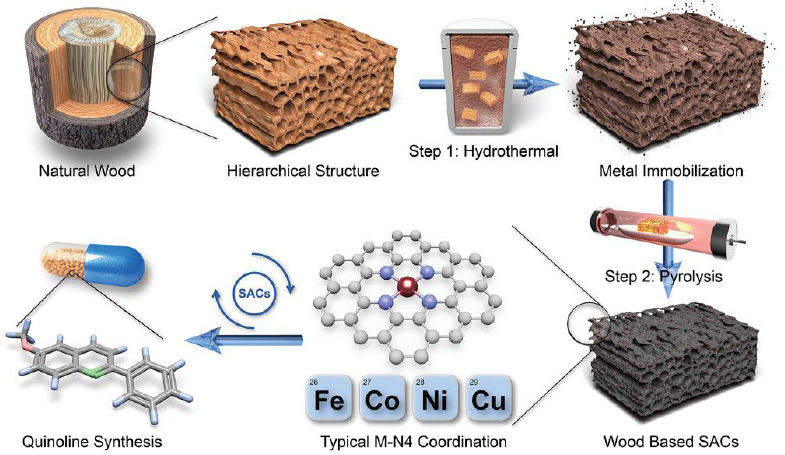
Figure 16. Schematic of the preparation of carbon-based single-atom catalyst from natural wood. Reprinted with permission from Ref. [92]. Copyright 2019, Wiley.